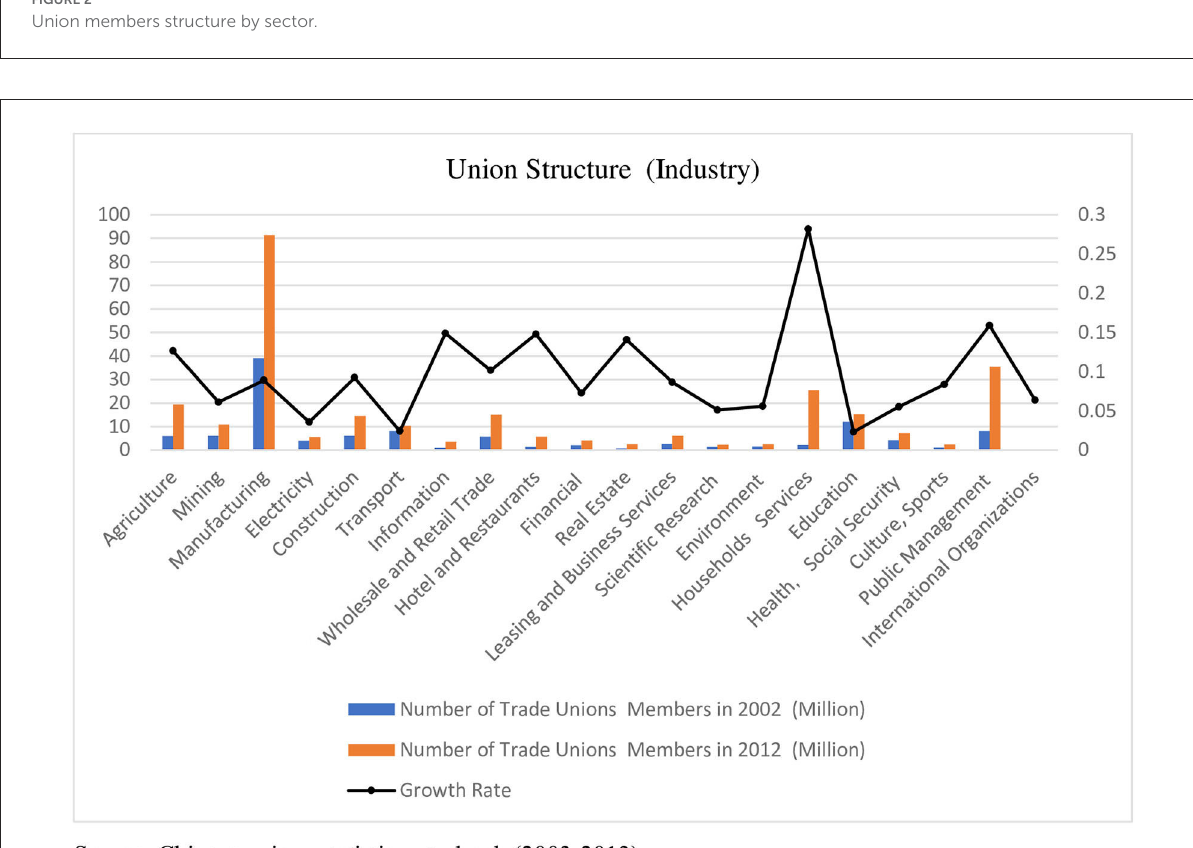
FIGURE3 Union members structure by